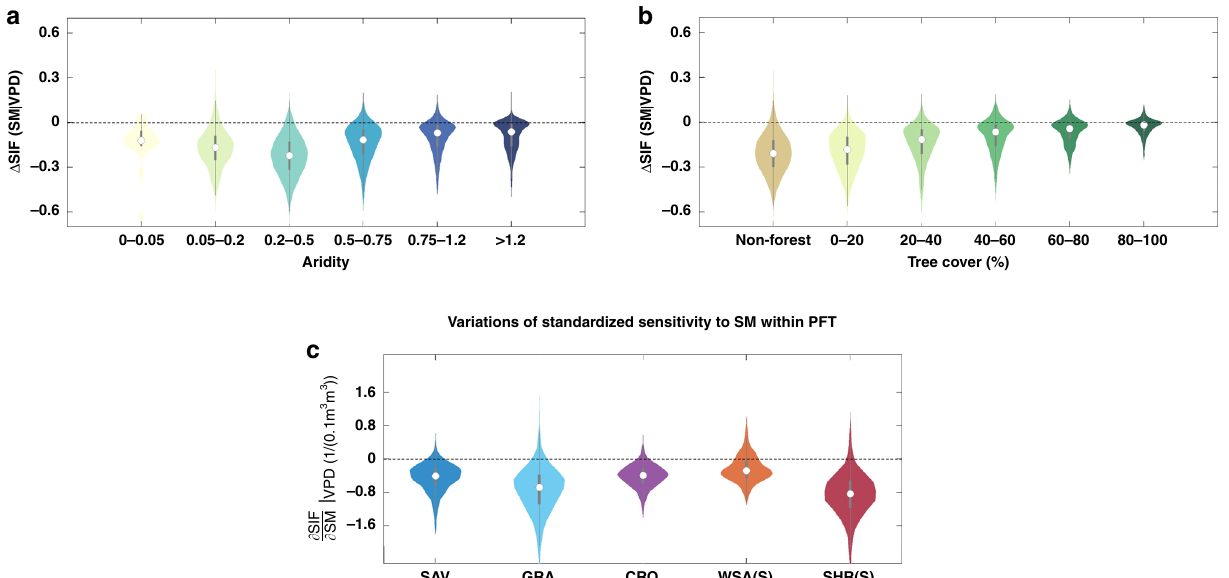
Fig. 5 Dependence of soil moisture dryness stress on climate and vegetation gradients. Violin plots of soil moisture (SM) limitation effects ( Δ SIF(SM| VPD)) across a aridity gradients and b tree cover gradients. c Violin plots of the sensitivity of solar-induced chlorophyll fl uorescence (SIF) to SM (i.e., δ SIF j VPD ) within different plant functional types: SHR(S), shrubland (south of 45° N); GRA, grassland; CRO, cropland; WSA(S), woody savanna (south of δ SM 45° N); SAV, savanna. White dots indicate the median values, gray boxes cover the interquartile range, and thin gray lines reach the 5th and 95th